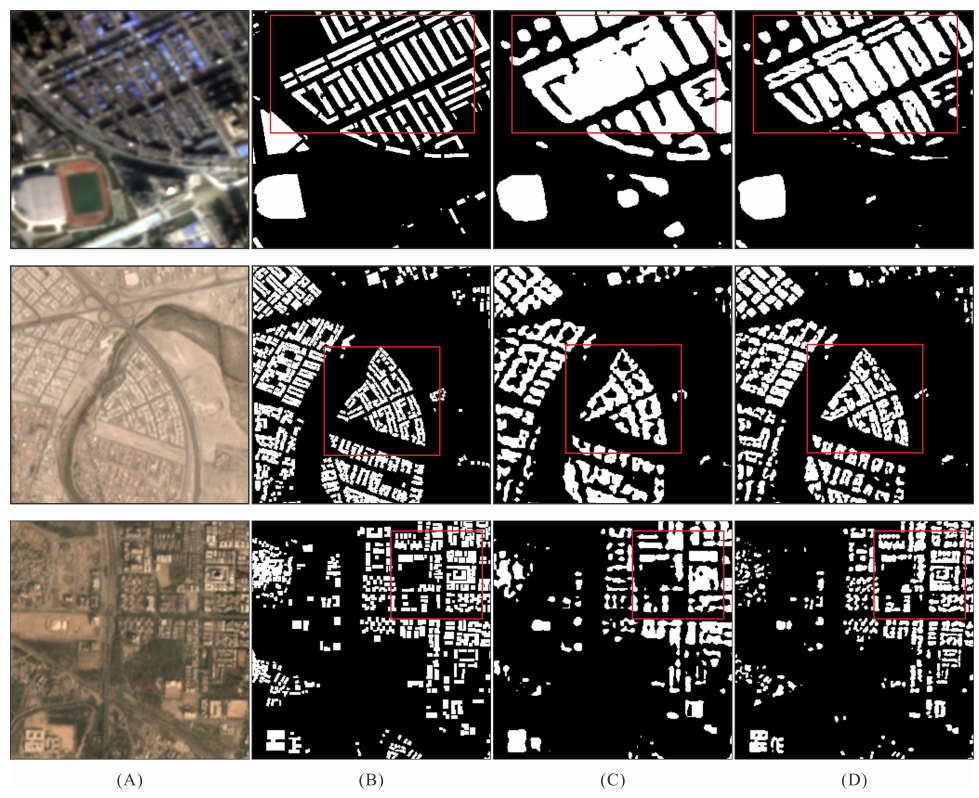
Figure 11. Sample images and results where the buildings are densely distributed. ( A ) Image tile. ( B ) Ground truth. ( C ) EPUNet. ( D ) SGFANet. EPUNet propagates all features of the building boundary without filtering, which limits the performance in LR imagery due to the fuzzy bound- ary details—particularly for the buildings in dense areas. The red squares indicate our notable